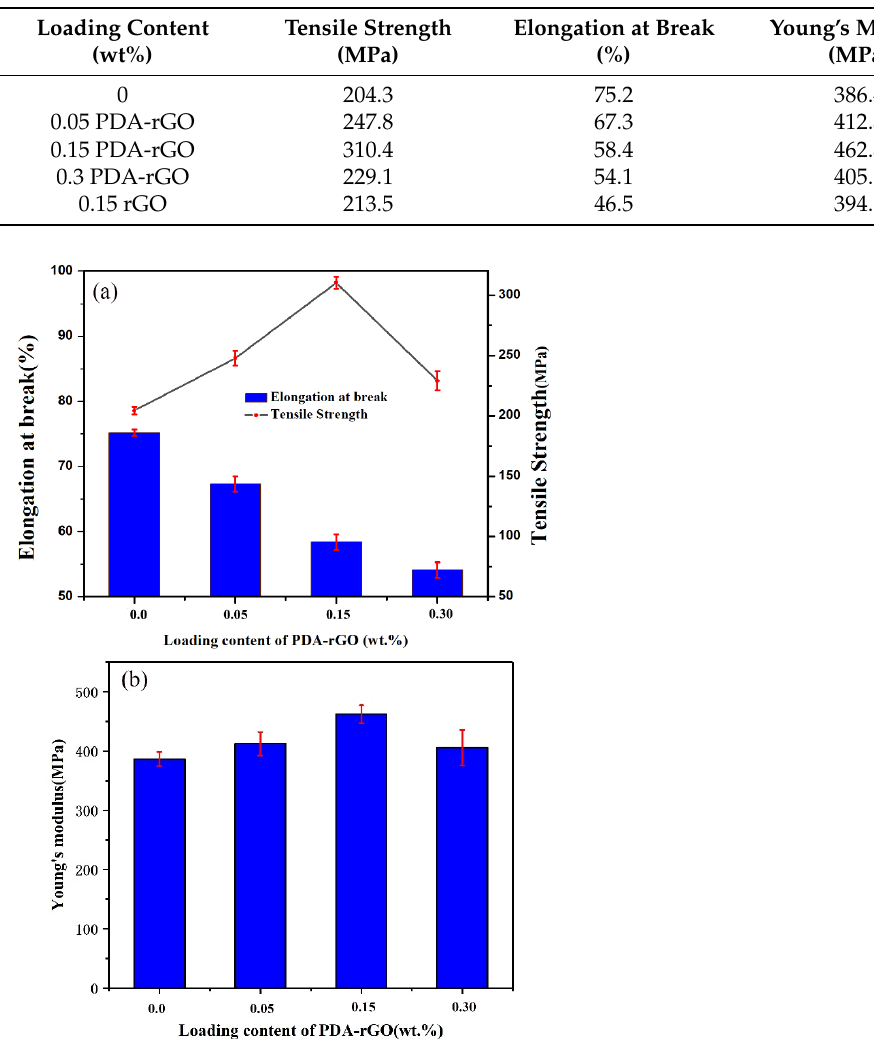
Table 1. Tensile properties of PA6 fiber, 0.15 rGO/PA6 composite fiber and composite fibers containing different PDA-rGO content.